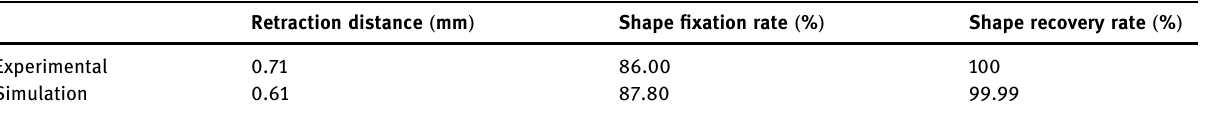
Table 6: Simulation and experimental comparison of shape memory characteristics